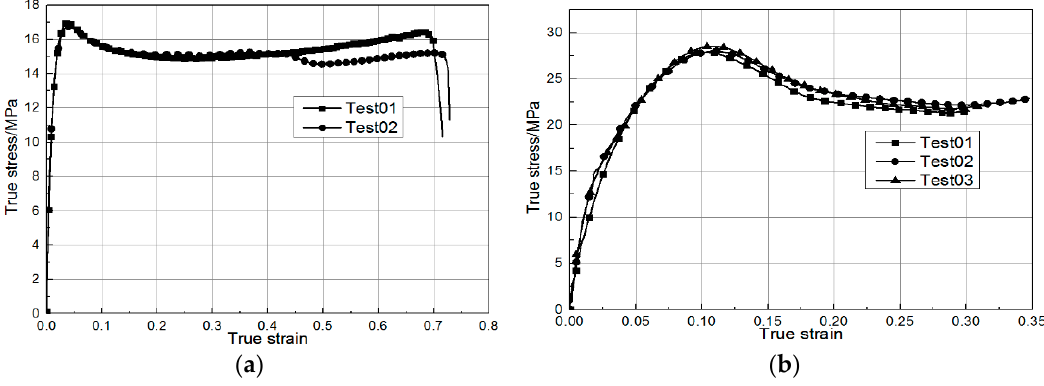
Figure 9. True stress–true strain curves of polypropylene material. ( a ) Tension. ( b ) Compression.